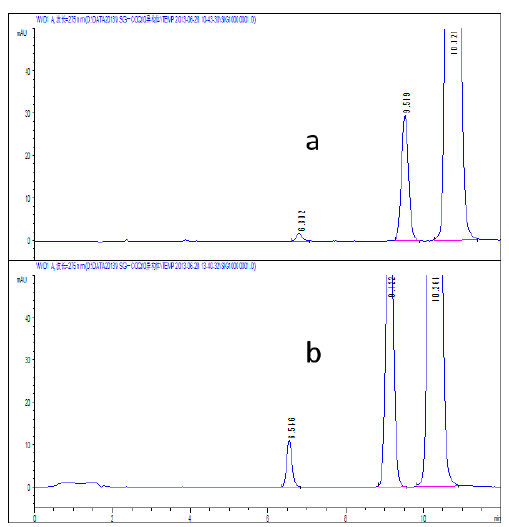
Figure 10. The system suitability spectrum obtained after 4 hours at different concentrations of 30% hydrogen peroxide ( a 2 μL ; b 5 μL ; c 10 μL) .